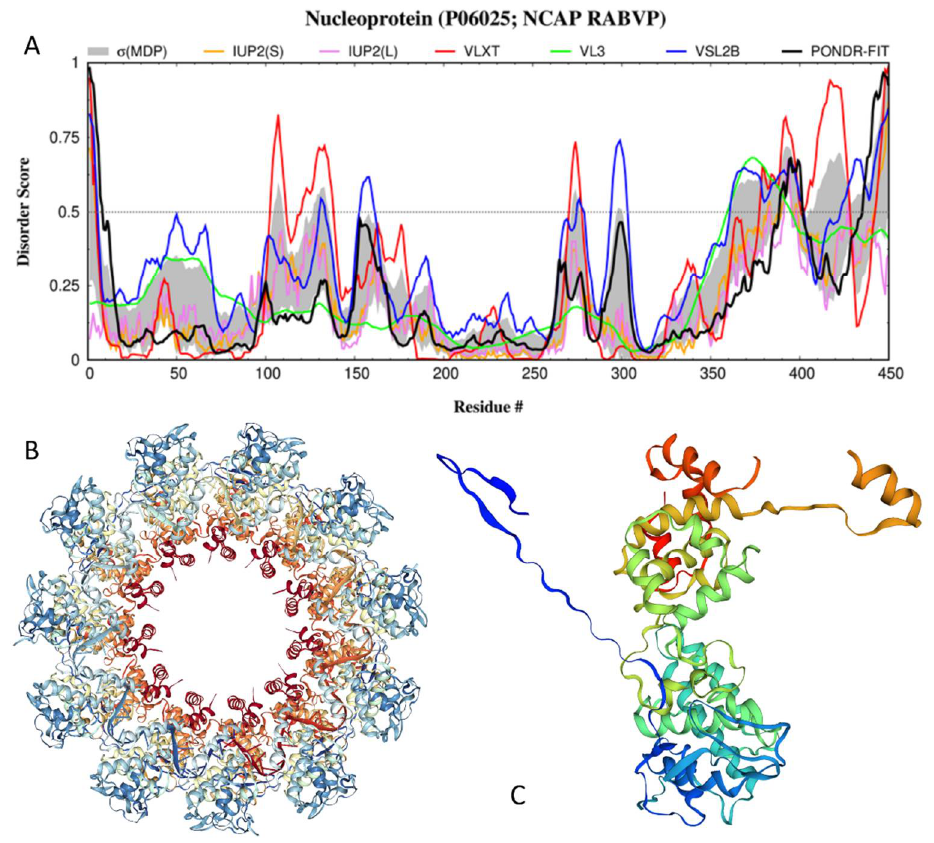
Figure 4. Structure and disorder in the N-protein from the RABV strain PV (UniProt ID: P06025). ( A ) Intrinsic disorder profile generated for the M-protein from the RABV strain VP by RIDAO. ( B ) Crystal structure of the N-protein from the RABV strain ERA (which is 99.11% identical to the N-protein from the RABV strain PV) in complex with RNA (PDB ID: 2GTT; [126]), where the protomers of the N-protein are organized in an undecameric ring. ( C ) Crystal structure of the N-protein protomer computationally taken out of the undecameric homo-oligomer and demonstrating the presence of two “arms” in the structure (residues 6–28 and 349–414).